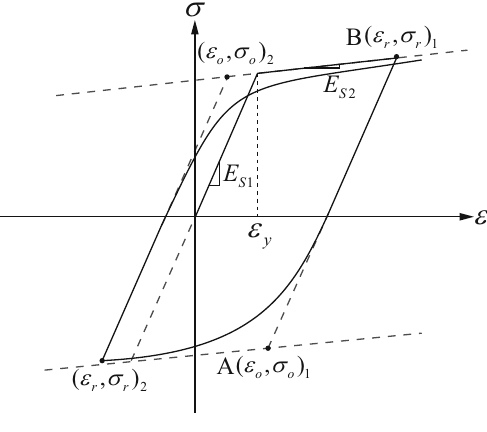
Fig. 3 Cyclic stress–strain relation of steel. Fig. 4 Fixed-end rotation at the beam-column